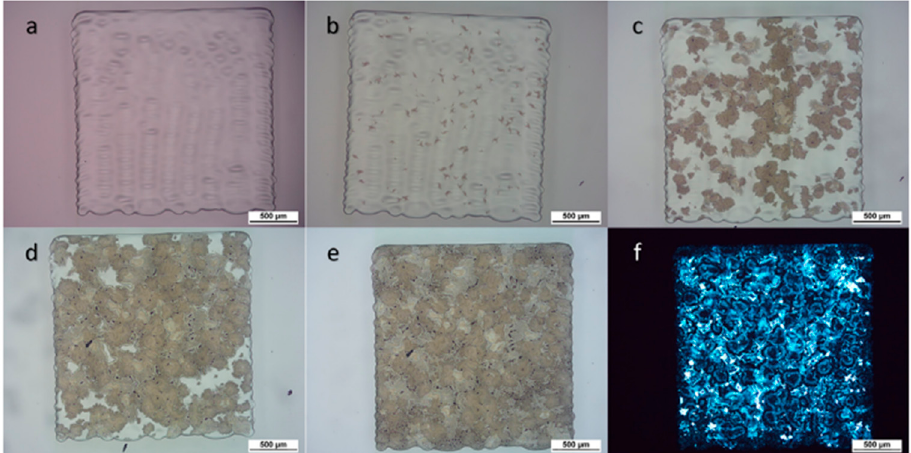
Figure 12. Optical reflection images of printed films on glass slide: ( a ) 30 min, ( b ) 1 day, ( c ) 4 days, ( d ) 8 days, ( e ) 12 days, ( f ) 12 days after orienting. All confirm the formation of a crystalline phase (cross-polarized transmission OM). Scale bar = 500 µm [156].